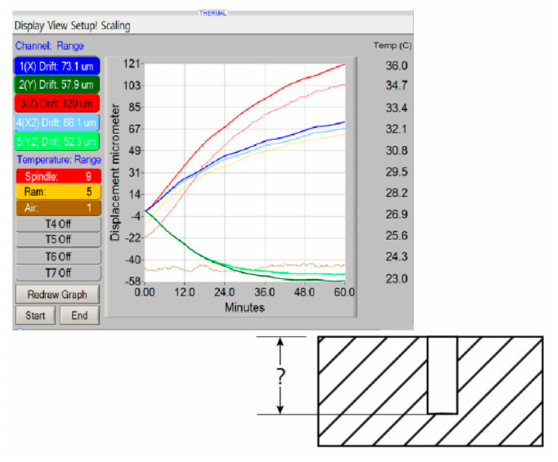
Figure 13. View of the Spindle Error Analyzer (SEA) system screen during examination of the influence of temperature on the position of the tool in the spindle (without revolutions) (e.g., influence on the dimension of depth for the made hole)